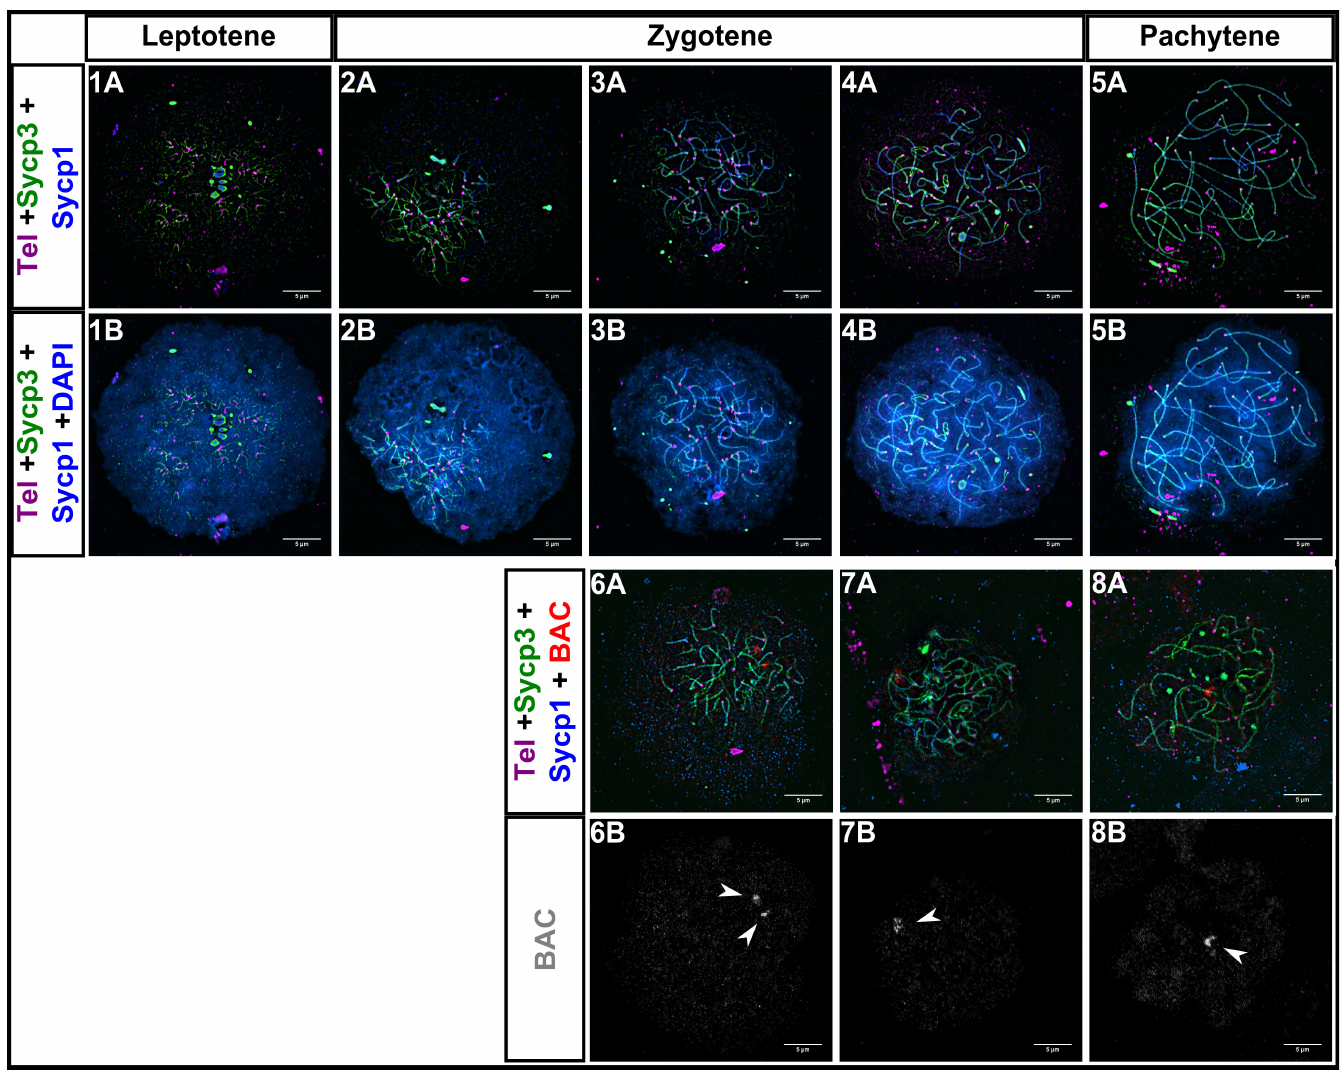
Fig 4. Homologous chromosome synapsis and pairing in female zebrafish meiosis I. 1A-5B: Sycp3 (green) loading and synapsis (Sycp1; blue), begin near telomeres (Tel; magenta) and progress inwards, similarly to what is seen in zebrafish males. 6A-8A: BAC (red), Sycp3 (green), Sycp1 (blue), Telomeres (Tel; magenta). 6B-8B: Same images as 6A-8A with only the BAC shown (gray; arrowheads). Scale bar = 5 μ